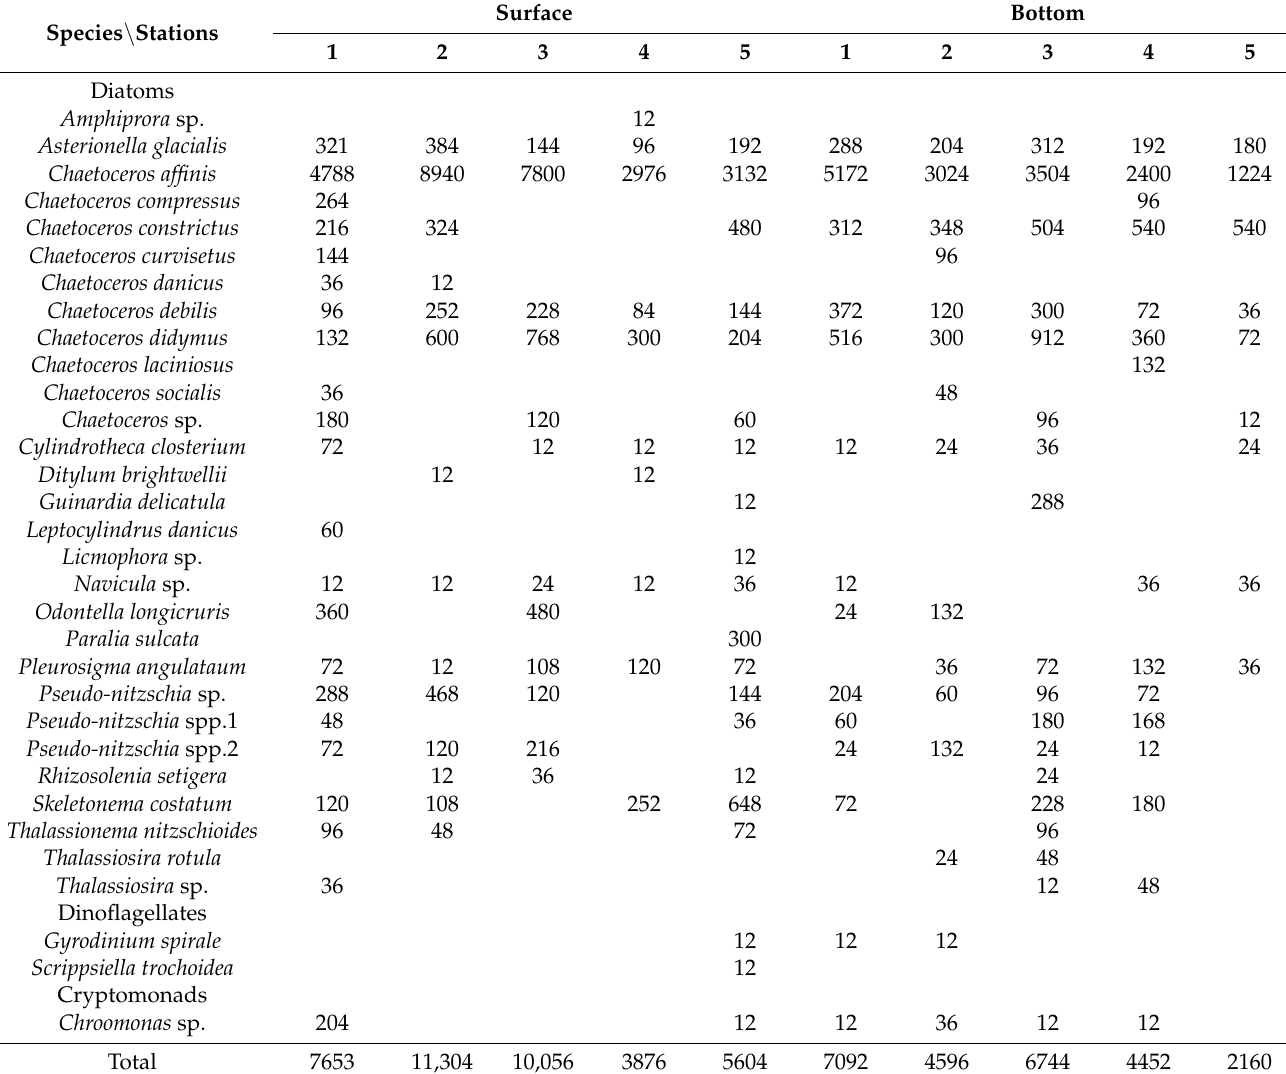
Table 1. Phytoplankton assemblages in the surface and bottom waters in Tongyeong Sanyang-eup in May 2006 ( × 100